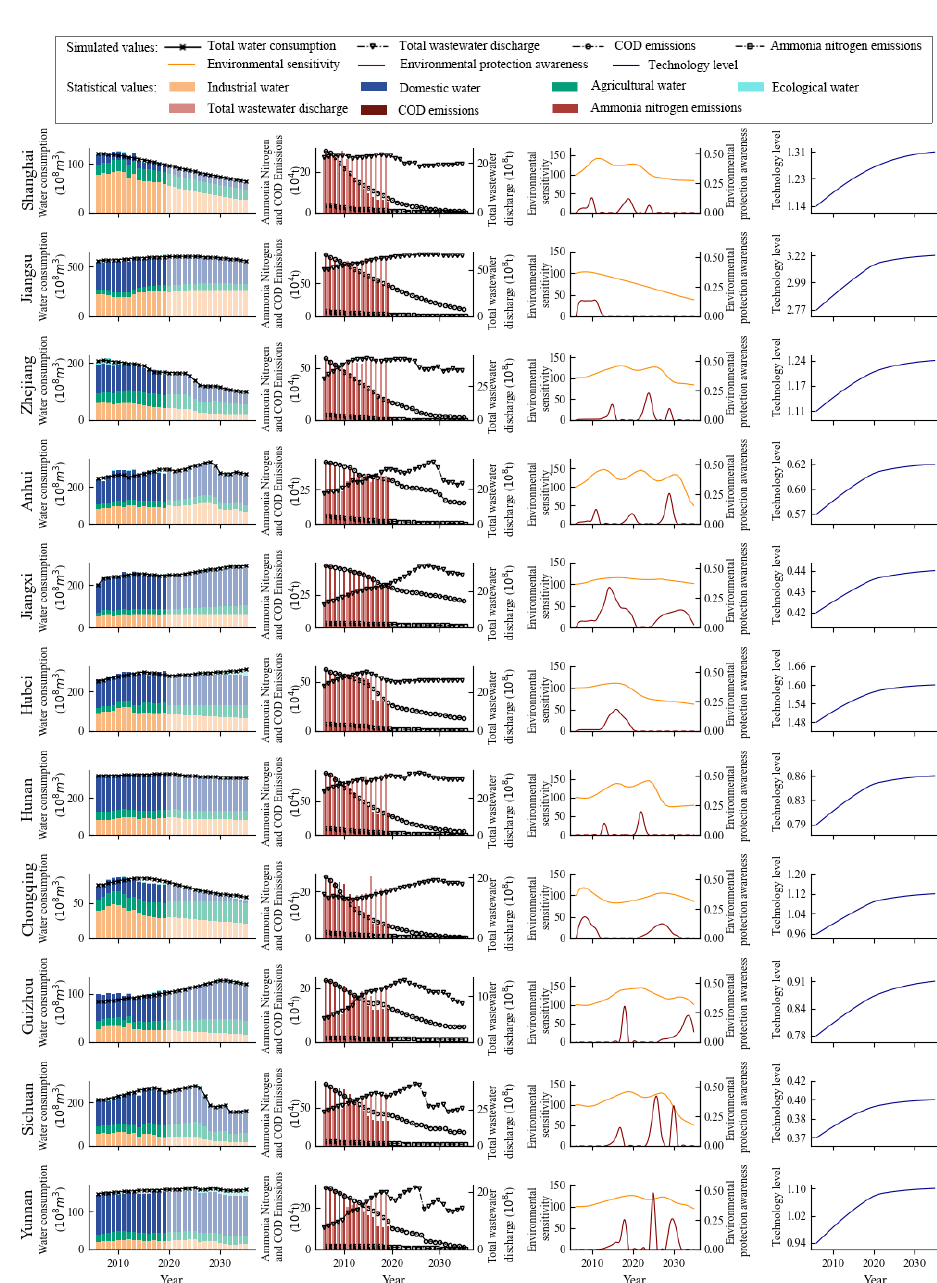
Figure 4. Simulation results of co-evolution of water resources-society-environment in 11 provincial administrative regions of the YREB. Note: In order to reflect the change in the proportion of water use during the forecast period, the simulated values of various water consumption results after 2020 are represented with corresponding colors with lower saturation.